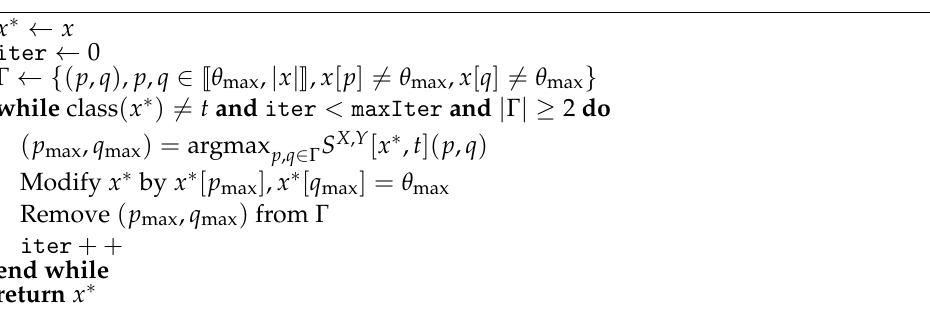
Algorithm 3 NT-WJSMA and NT-TJSMA